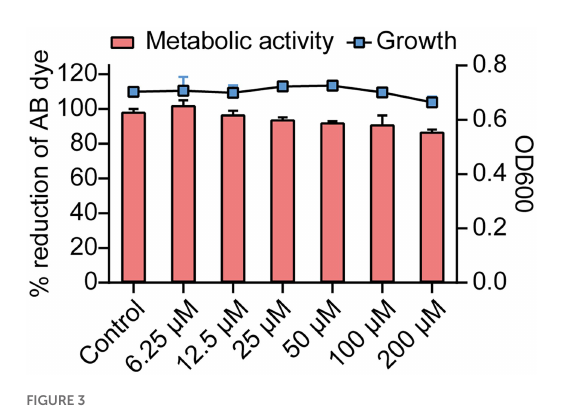
FIGURE 3 Growth and metabolic activity of E. coli in the presence of Ech. The line graph shows the growth of E. coli with Ech measured using a microbroth dilution assay. The bar graph shows